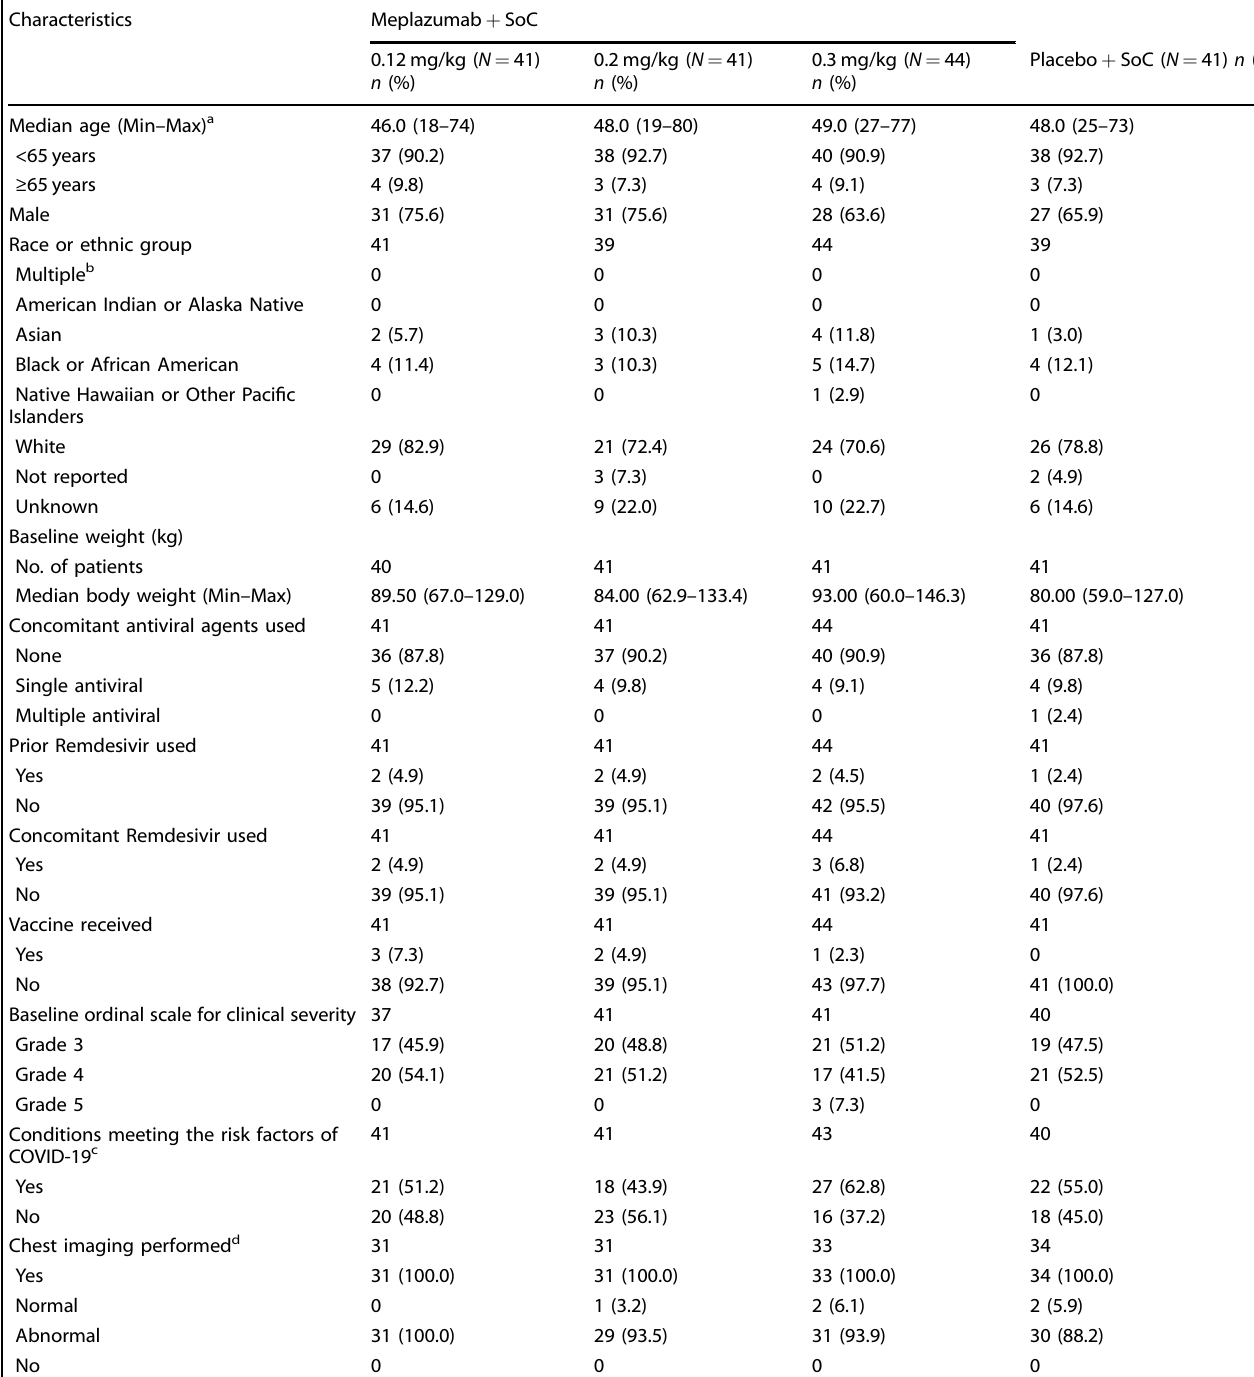
Note: Baseline is de fi ned as the last non-missing measurement before randomization (including unscheduled measurements, if any) Note: For fi rst level summaries, percentages are based on the number of patients with available data (n) in the analysis set by treatment group. For second level summaries, percentages are based on the number of patients in the fi rst level a Age, in years, is relative to the date of signed informed consent